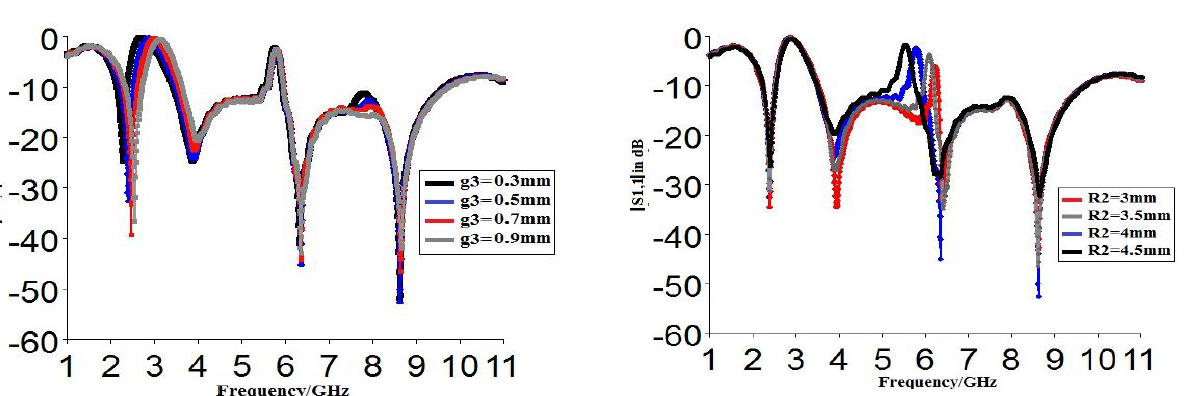
Figure 8: Simulated reflection coefficient for different g 3